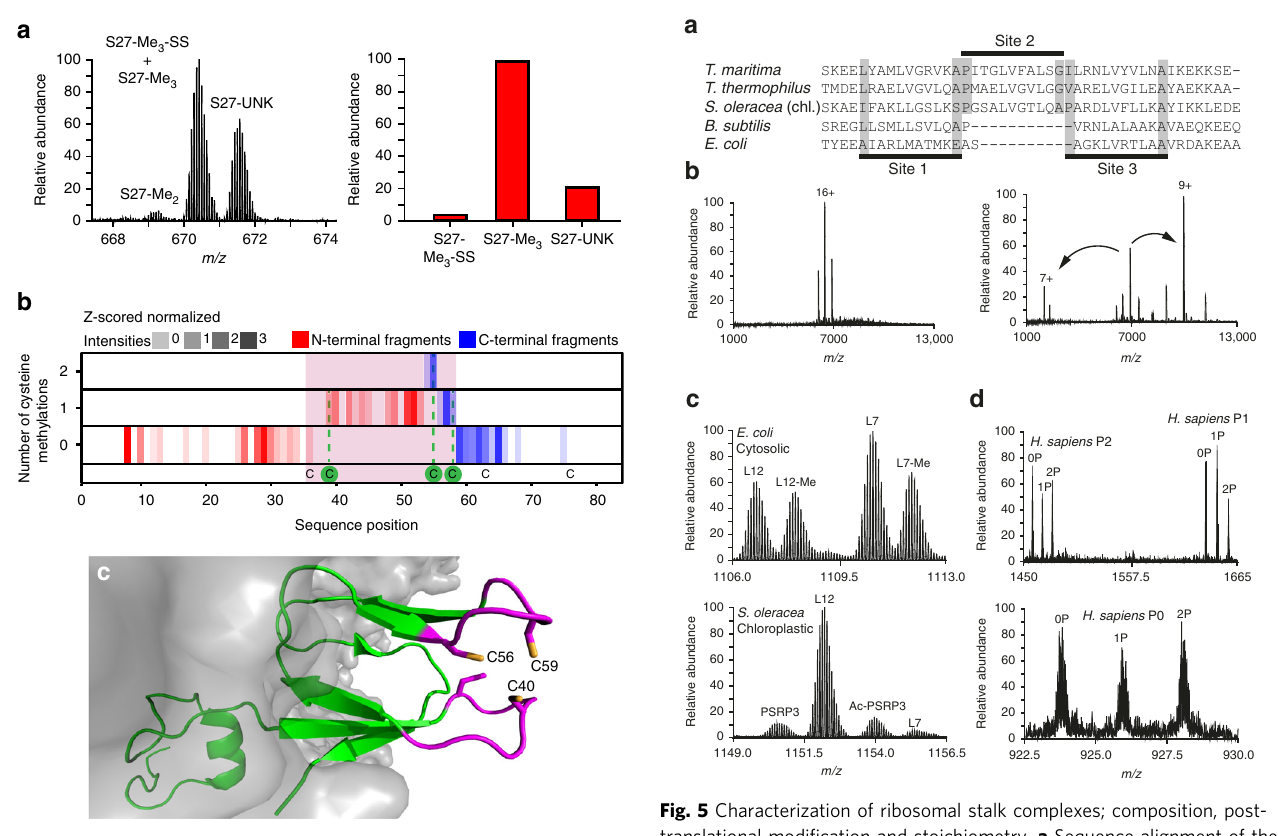
Fig. 4 Human S27 harbors several methylated cysteines in its Zn- fi nger domain. a Intact mass spectra of S27 reveals three proteoforms with distinct masses (left). Based on the mass differences from the sequence mass of S27 these are identi fi ed as di- and tri-methylated forms of the protein (S27-Me 2 and S27-Me 3 ) and a third proteoform carrying an unknown modi fi cation (S27-UNK). An additional lower abundant disul fi de- linked form was detected in fragmentation maps of the trimethylated form (S27-Me 3 -SS). b Top-down analysis of the S27-Me 3 fragmentation spectra pinpoints the methylation to the cysteine residues 40, 56, and 59. Fragments are mapped along the protein sequence (vertical bars) and methylated amino acids are identi fi ed by a mass shift of 14 Da. c Structure of the human 40S subunit with protein S27 in green and its cysteine containing zinc fi nger domain in magenta (PDB 5A2Q). The zinc- fi nger cysteines are shown as sticks and the methylated cysteine residues